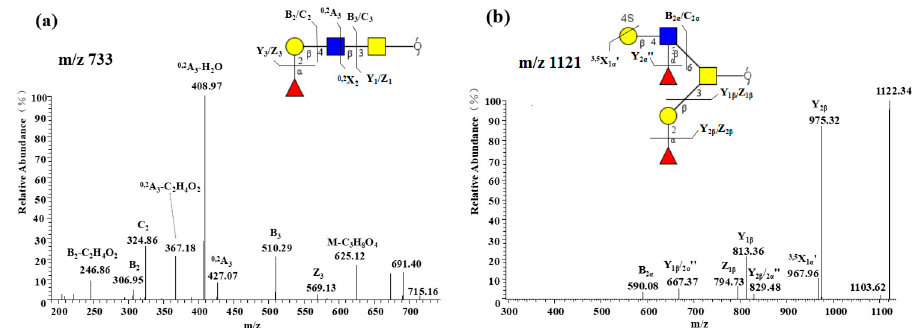
Figure 5. MS/MS spectra of two fucosylated oligosaccharides recorded in the negative ion mode: ( a ) oligosaccharide with α 1-2 fucose linkage to Gal residue; ( b ) oligosaccharide with α 1-2 fucose linkage to Gal residue and α 1-3 fucose linkage to GlcNAc residue.